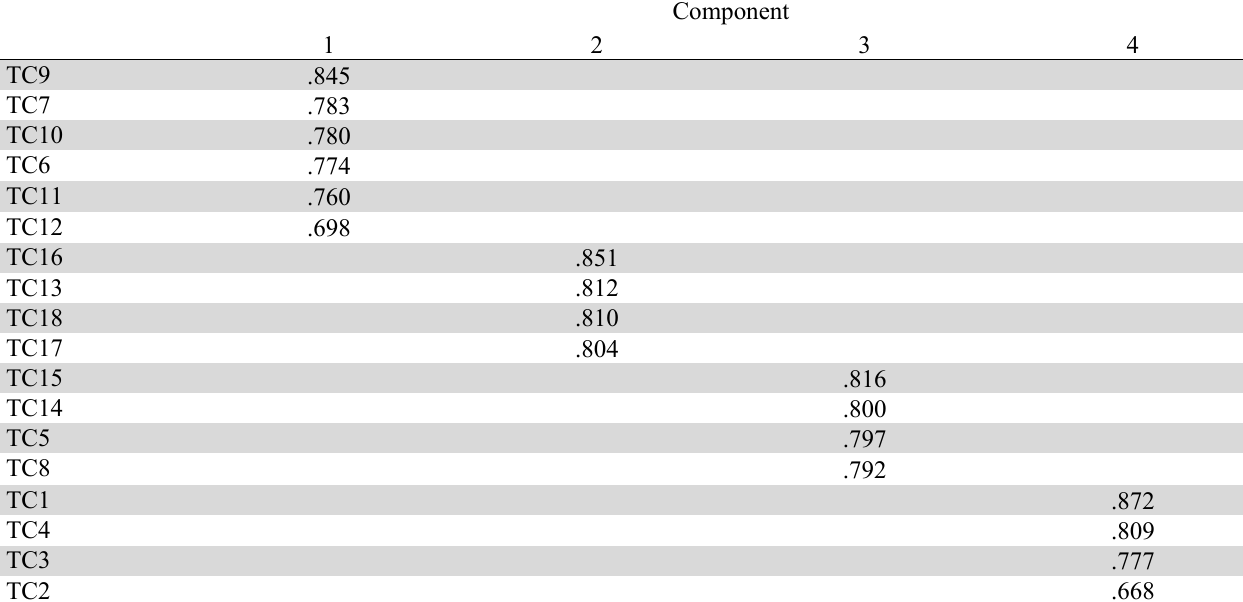
Rotated Component